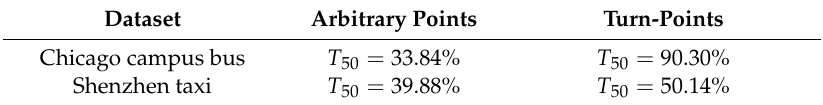
Table 2. Comparative result of T 50 using high-frequency and low-frequency trajectory